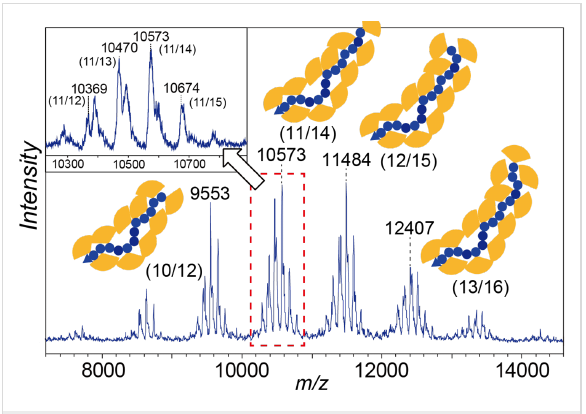
Figure 4: MALDI–TOF MS analysis of the dendronized polystyrene with peripheral bromo